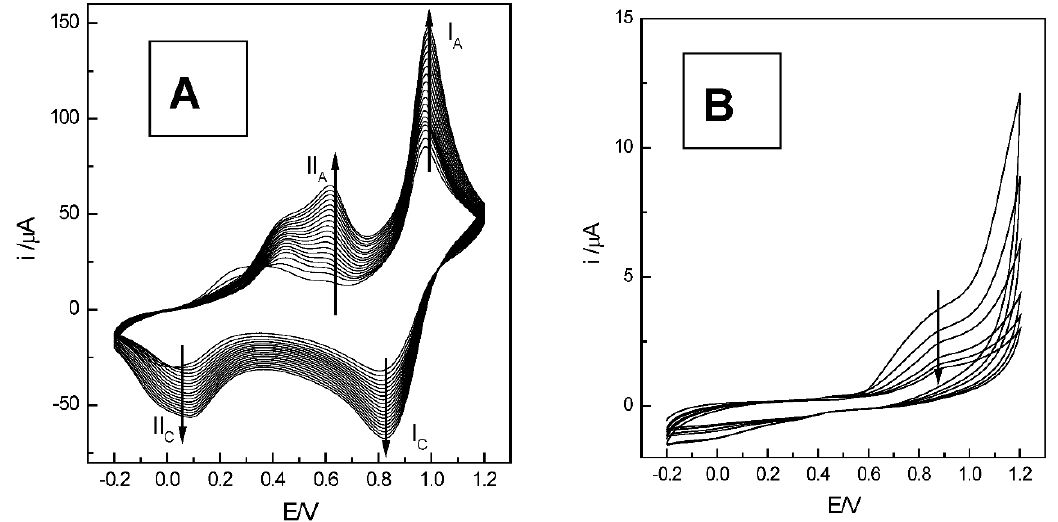
Figure 2. ( A ) Continuous cyclic voltammogram of Mn-LS in the presence of supporting electrolyte (Na 2 SO 4 ); and, ( B ) Continuous cyclic voltammogram of LS-H in the presence of supporting electrolyte (Na 2 SO 4 ). Arrows indicate the direction of current change on consecutive scans.